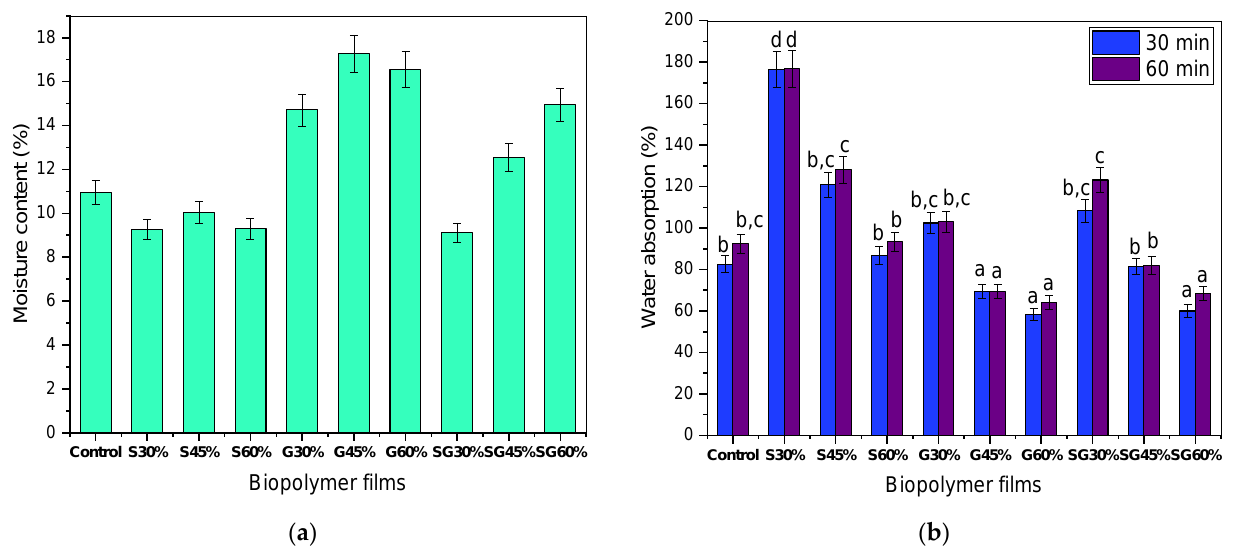
Figure 3. ( a ) Moisture content and ( b ) water absorption of cornstarch biopolymer films. a,b,c,d Values with different letters in the figures are significantly different ( p < 0.05).